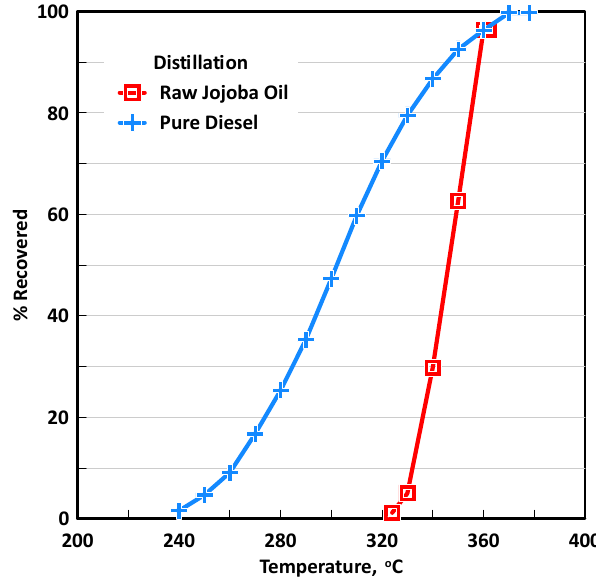
Figure 3. Distillation of pure diesel fuel and raw Jojoba oil.